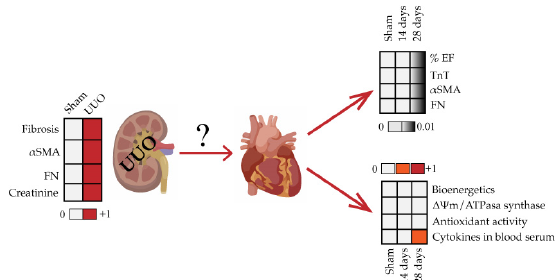
Figure 7. Integrative scheme. In summary, the results of our study show that notwithstanding the establishment of the UUO model in rats (determined by fibrosis markers), cardiac function (assessed by %EF, TnT, α SMA, and FN), and mitochondrial integrity in these animals were not affected. However, the animals showed an increase in inflammation up to 28 days measured in blood serum. UUO: unilateral ureteral obstruction; α –SMA: alpha-smooth muscle actin; FN: fibronectin; %EF: percentage of ejection fraction; TnT: troponin T; ∆Ψ m: transmembrane